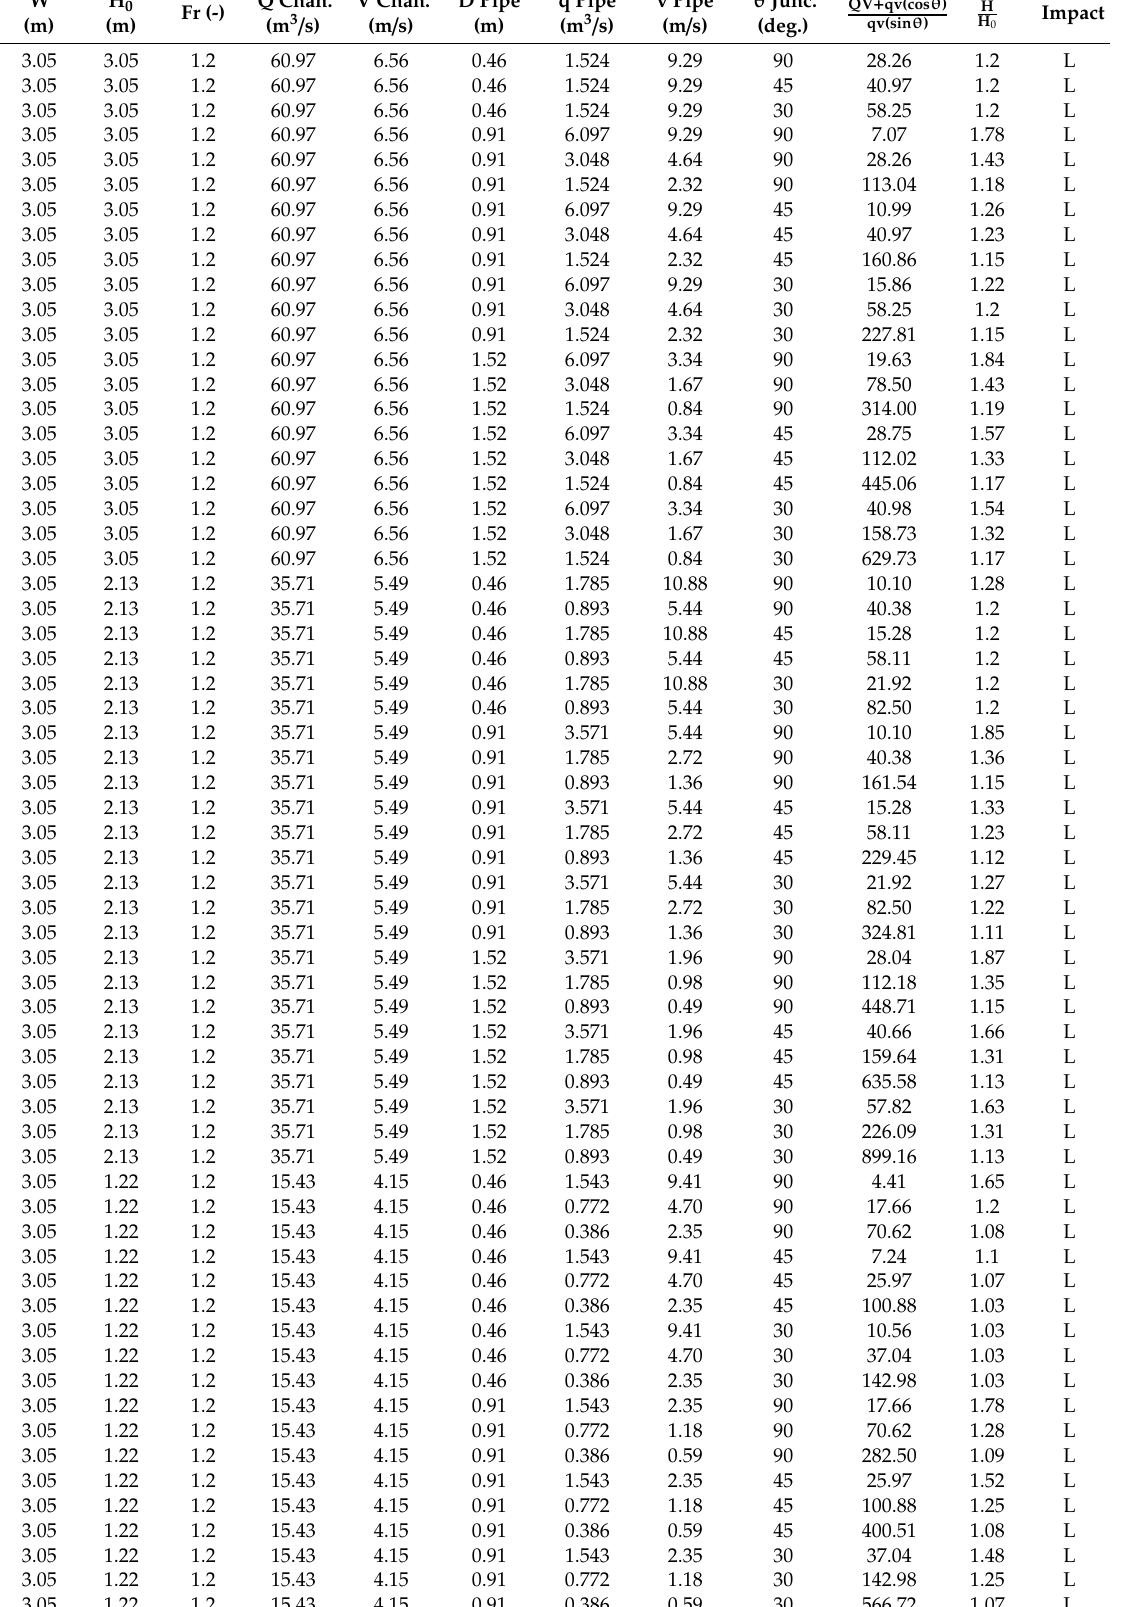
Table A4. FLOW-3D simulation results for W = 3.05 m (10 (cid:48) ) and Fr =